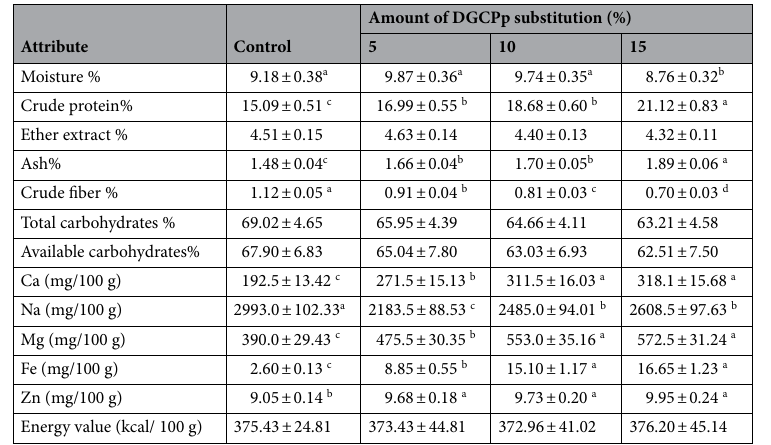
Table 2. Chemical composition of crackers prepared with DGCPp (g/100 g) on a dry weight basis. Data are expressed as mean ± SEM. Mean values with different superscript letters [a (the highest values)—d (the lowest value)] in the same row are significantly different at ( p ≤ 0.05). All groups were compared to each other.